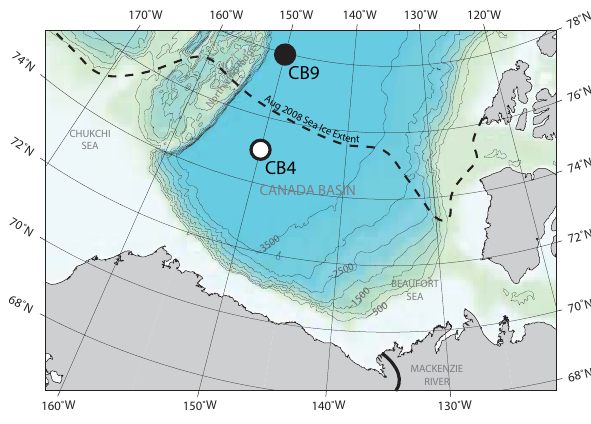
Fig. 1. Sampling locations in the Canada Basin mapped with ap- proximate sea-ice extent in August 2008